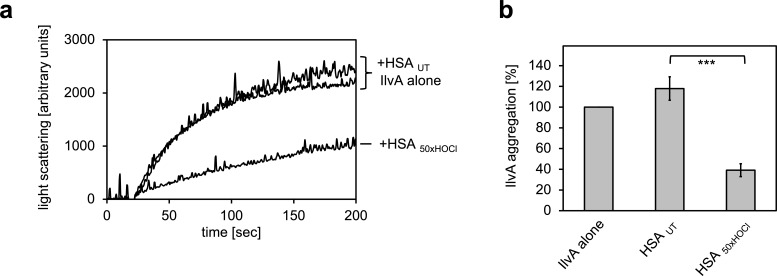
Serum albumin, when treated with a 50-fold molar excess of HOCl, significantly decreases aggregation of chemically denatured IlvA as measured by light scattering at 360 nm.(a) Representative measurements are shown. (b) Data represented as means and standard deviations from three independent experiments. Student’s t-test: ***p<0.001. Aggregation of citrate synthase in the absence of HSA was set to 100% and all the data are presented as percentage of this control. Labels of aggregation curves are written in the order of the final intensity of light scattering of the respective treatment.
10.7554/eLife.47395.006Figure 2—figure supplement 1—source data 1.Numerical light scattering data obtained during protein aggregation assays represented in Figure 2—figure supplement 1.